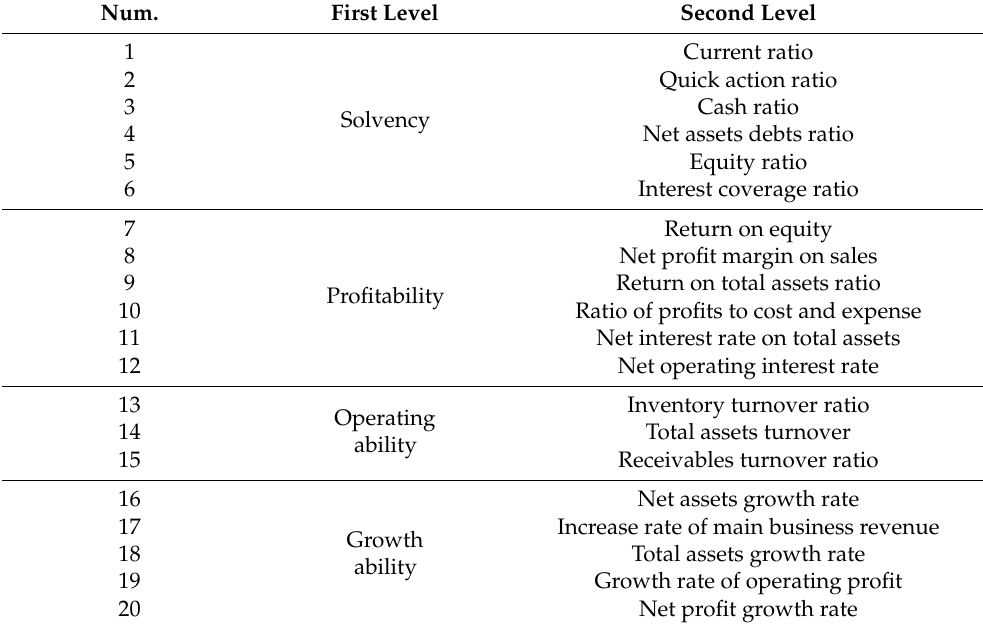
Table 3. Features.